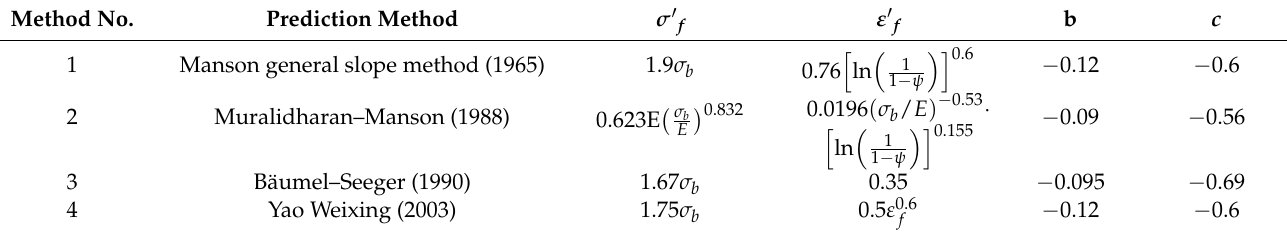
Table 4. The prediction methods and parameters of LCF